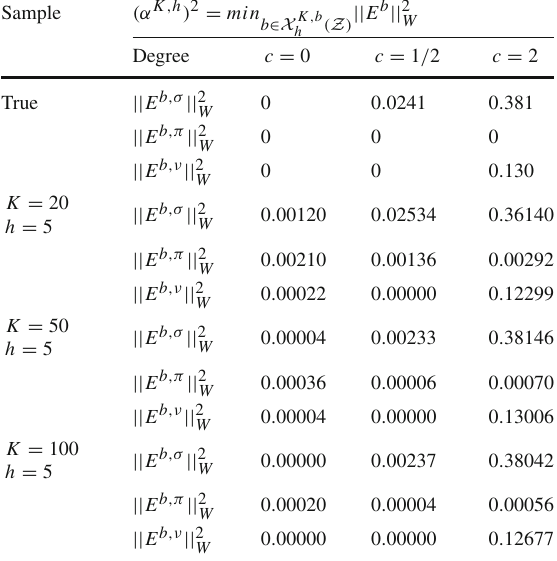
Table 3 Numerical approximation of the square of the minimal Slutsky norm of a set of extensions, for different values of